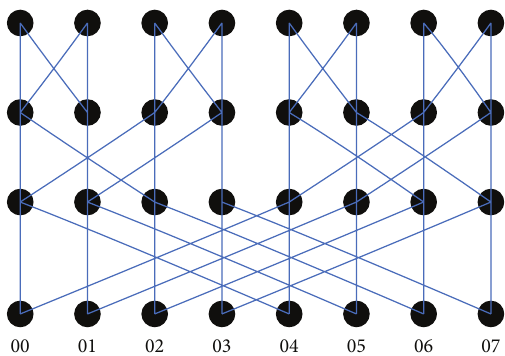
Figure 2: Three-layer butterfly network